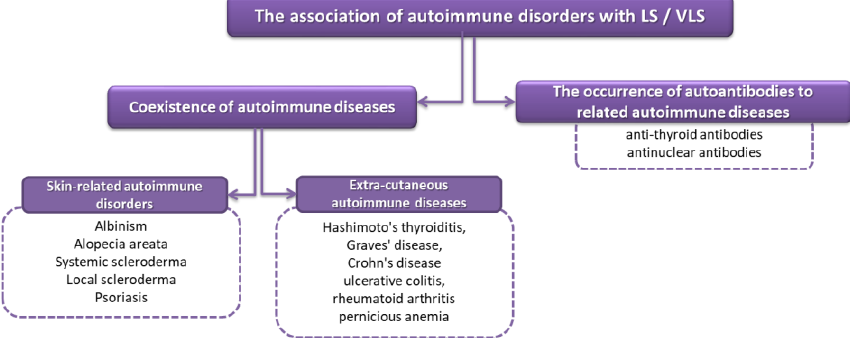
Figure 3. Autoimmune links with LS/VLS based on [16,52].